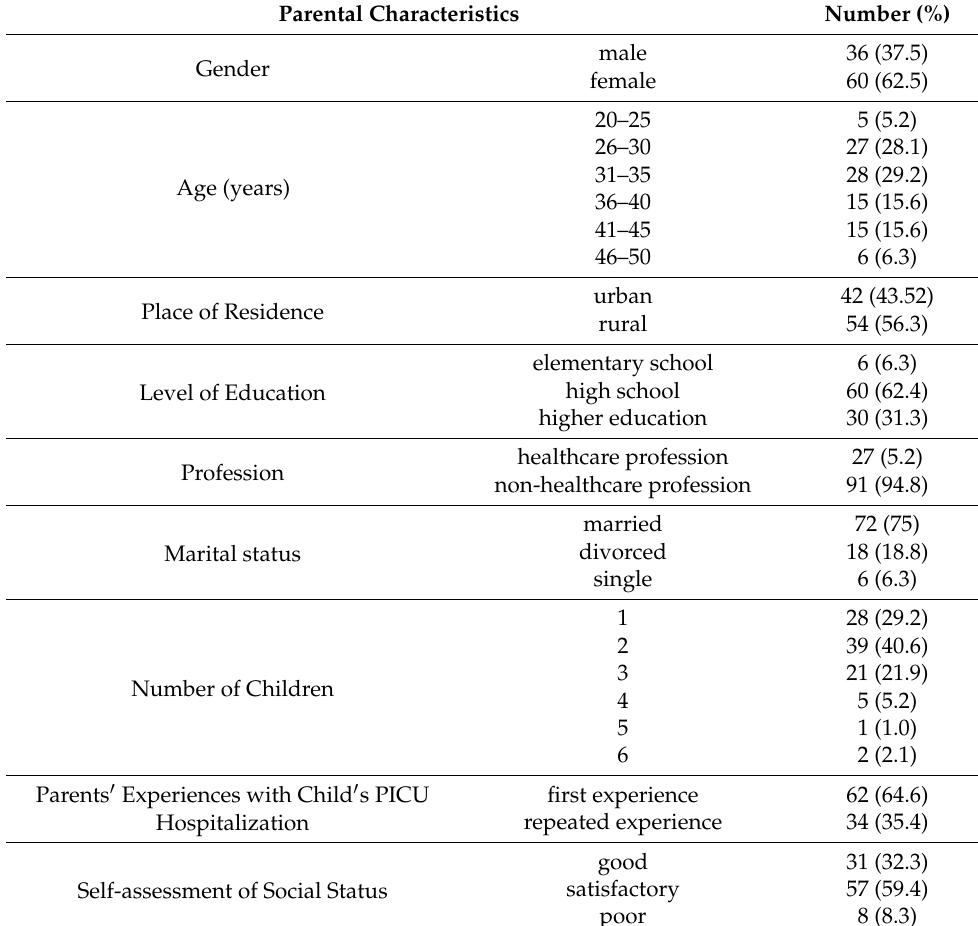
Table 1. Sociodemographic characteristics of parents (N = 96).